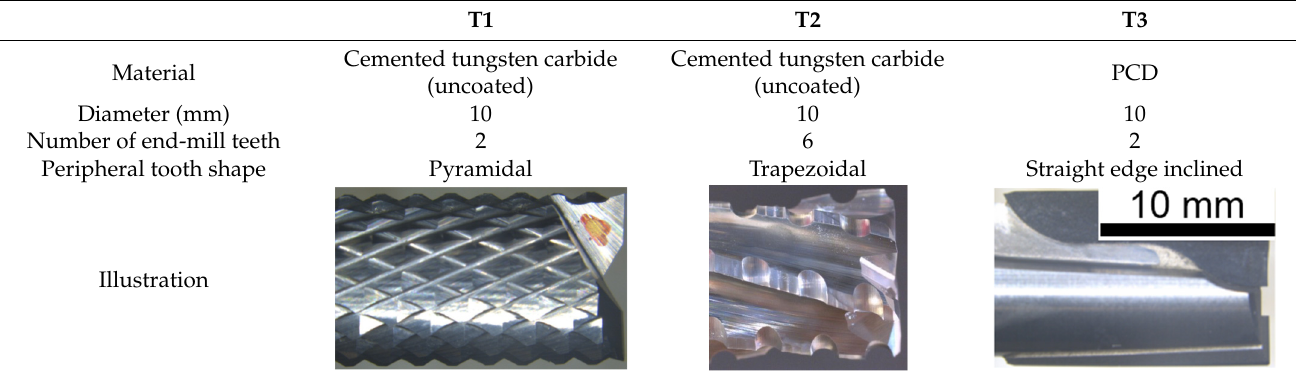
Table 3. Characteristics of the cutting tools used during the milling of the GFRP